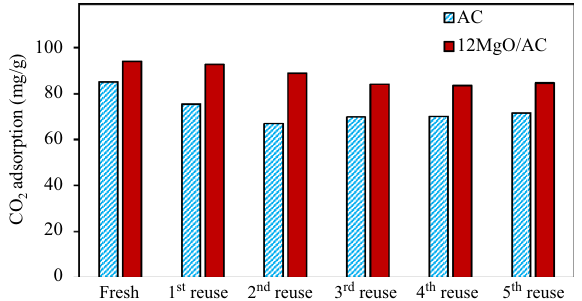
Figure 11. Benchmarking of CO 2 adsorption capacity 25 °C and 1 atm between 12MgO/AC and unimpregnated AC 27 after the thermal